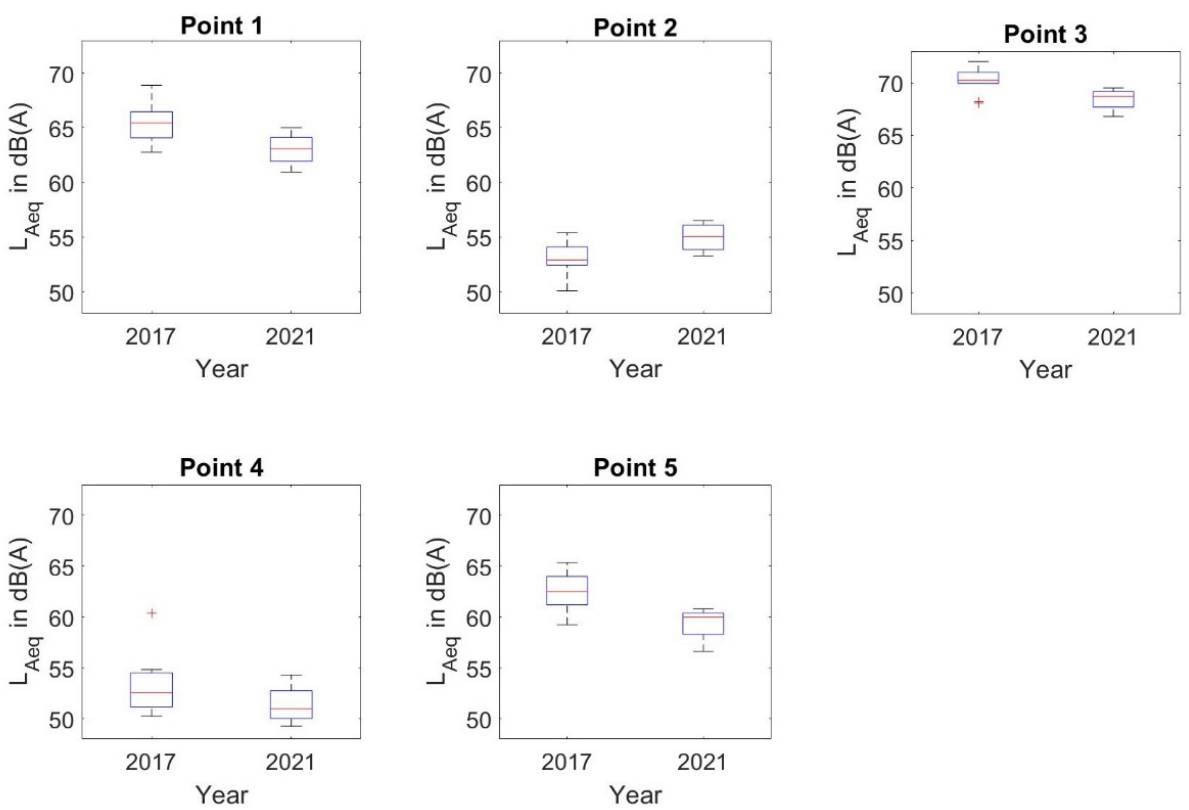
Figure 3. Comparison of sound pressure levels (L Aeq ) measured during soundwalks in 2017 and 2021 for all five soundwalk locations (boxplot). The box displays the spread of data. The lower and upper box boundaries represent the 25th and 75th percentiles (interquartile range IQR), the whiskers represent the range of the remaining data up to a length of 1.5 × IQR, data falling out-side the whiskers are marked as outlier values with a “+”.